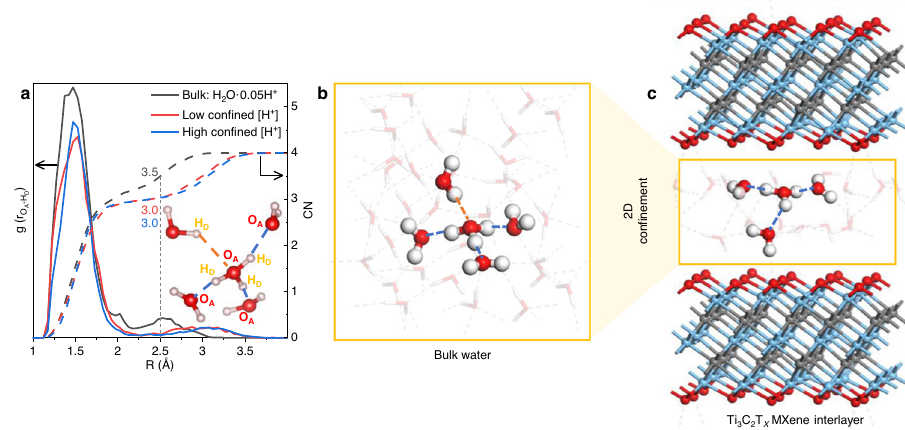
Fig. 4 | Hydrogen bonding in 2D con fi nement. a Radial distribution function of non-covalently bonded O A -H D distances between a hydronium ion and its four nearest-neighbour water molecules (solid lines) and the resulting coordination numbers of the hydronium ion (dashed lines) in bulk water with 0.05 H + per H 2 O (black), MXene-con fi ned water at low [H + ] (Ti 3 C 2 O 2 ·1.42H 2 O·0.08H, red), and MXene con fi ned water at high [H + ] (Ti 3 C 2 O 2 ·1.42H 2 O·0.25H, blue). The vertical